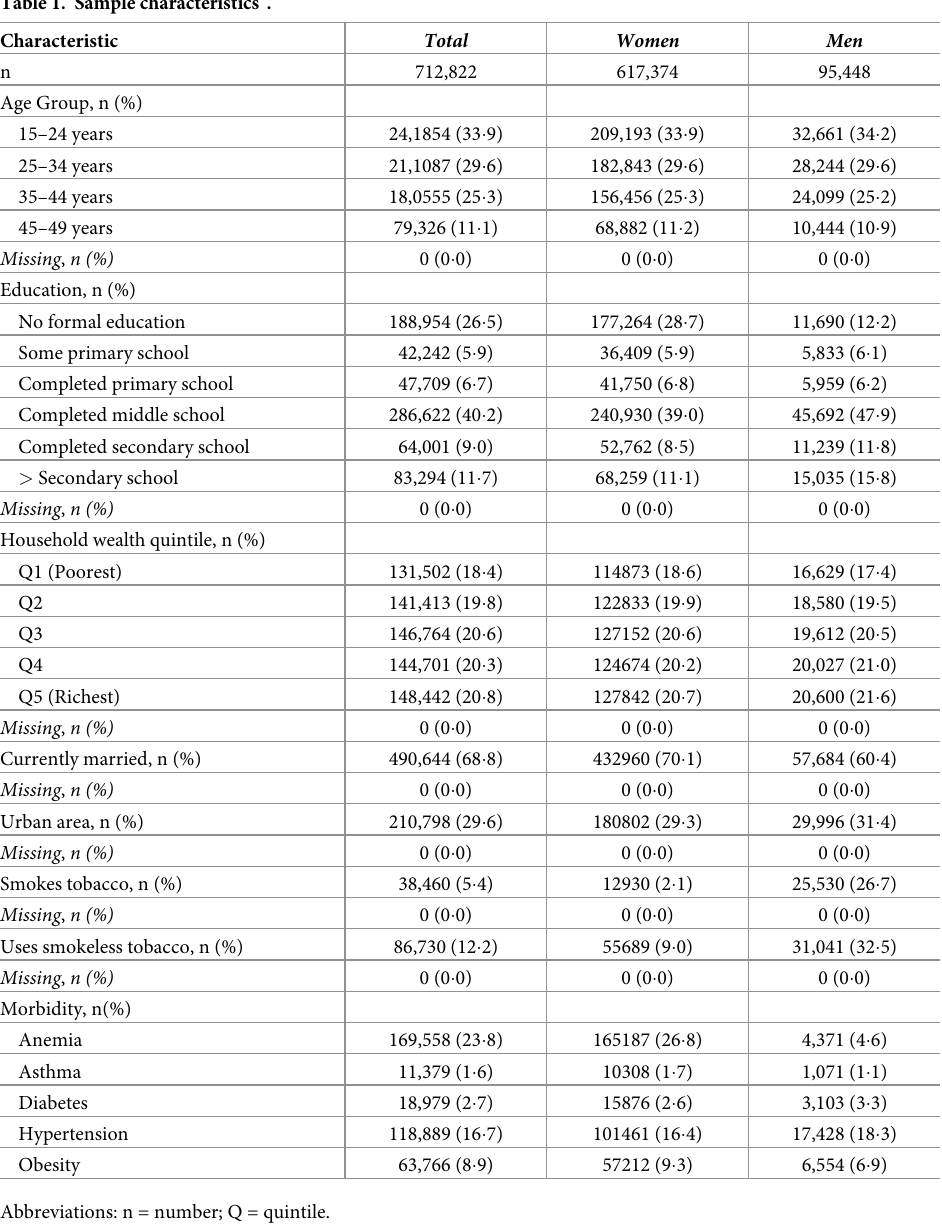
Table 1. Sample characteristics 1